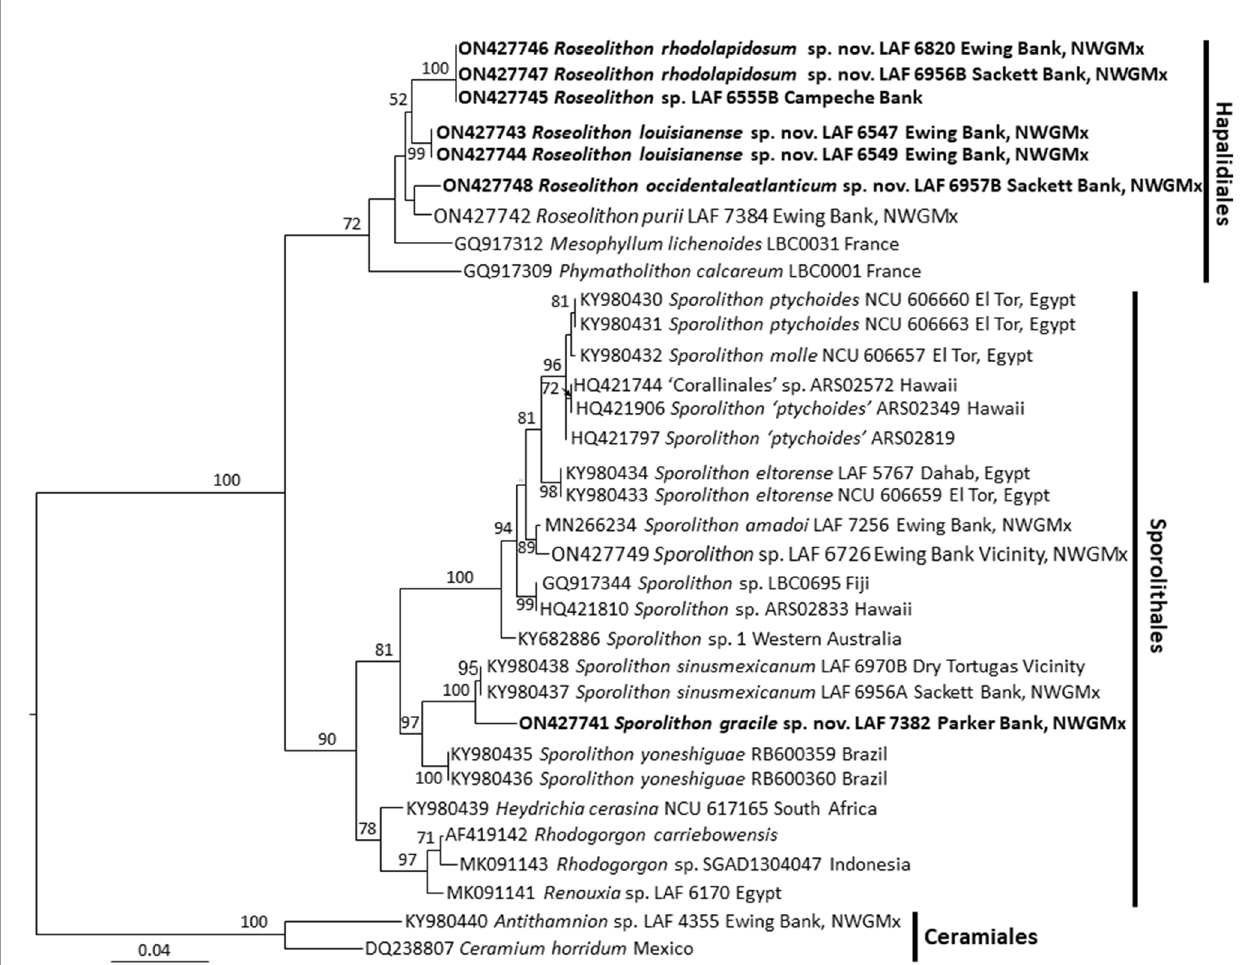
FIGURE 3 | Maximum Likelihood analyses of LSU. Node values represent bootstrap values out of 1,000 replicates. Newly described species shown in bold. NWGMx, northwestern Gulf of